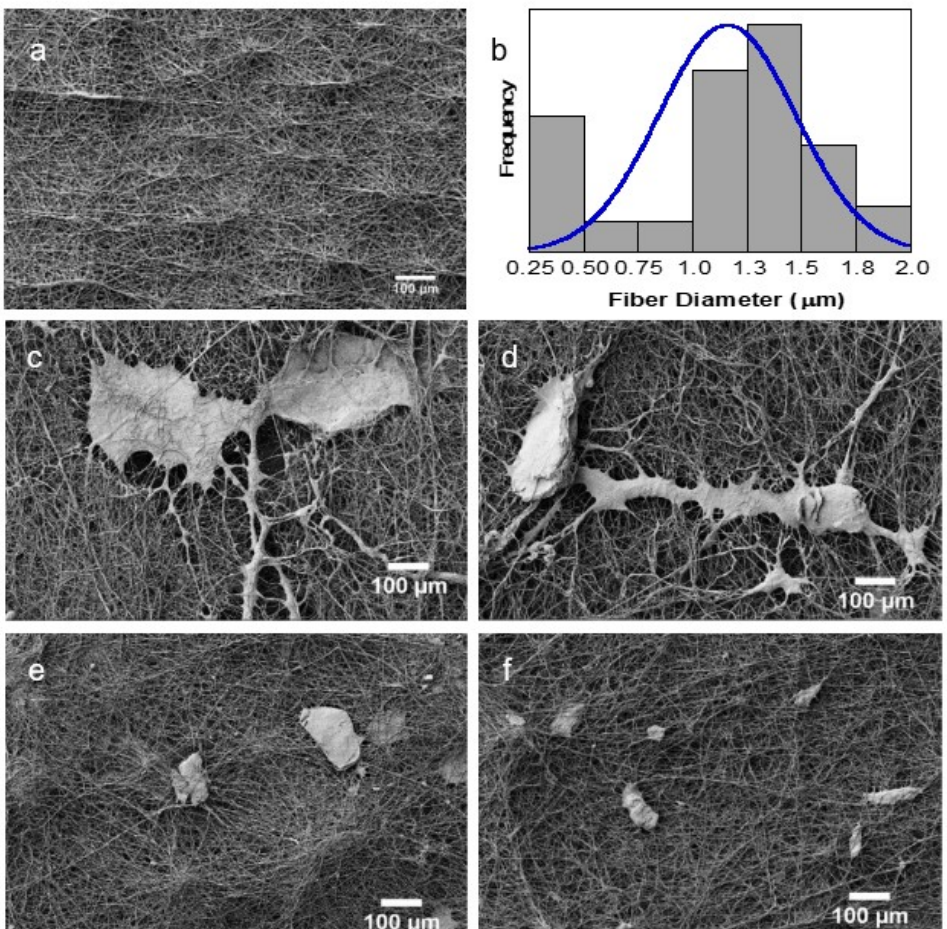
Figure 4. SEM images of ( a ) electrospun PCL mats and ( b ) the respective histogram with the fiber diameter distribution ( b ) as well as PCL mats with CS flakes of different sizes: ( c ) 150–200 µm, ( d ) 100–150 µm, ( e ) 50–100 µm and ( f ) <50 µm.